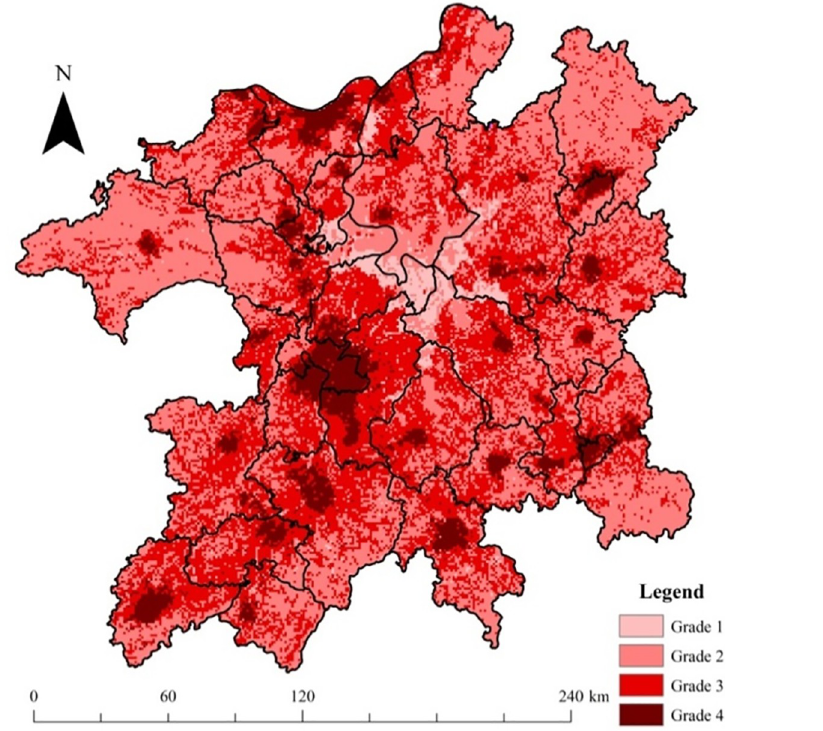
Fig 5. Integrated intensity grades of regional ecological risk source in the